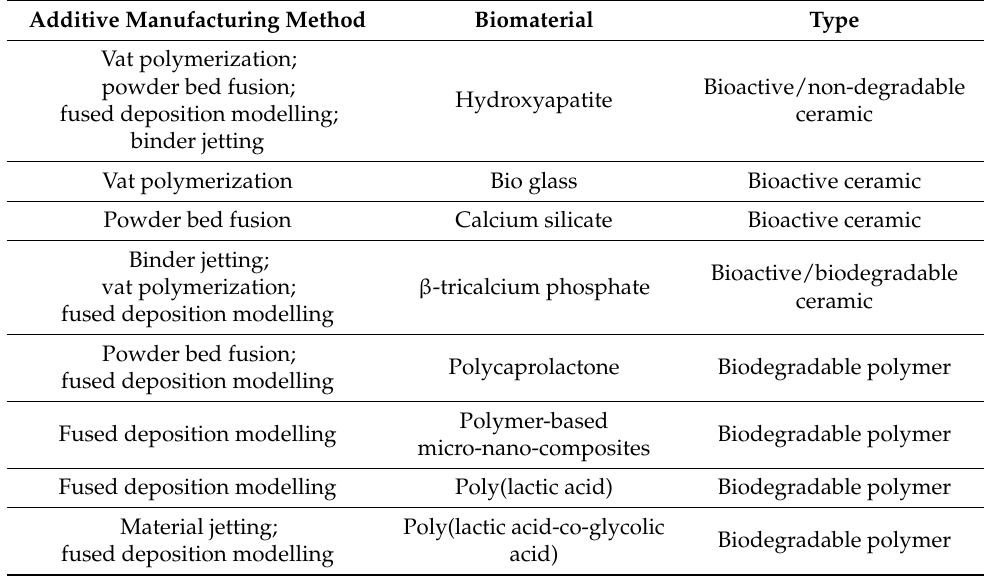
Table 1. Additive manufacturing methods for oral tissue engineering. Adapted from